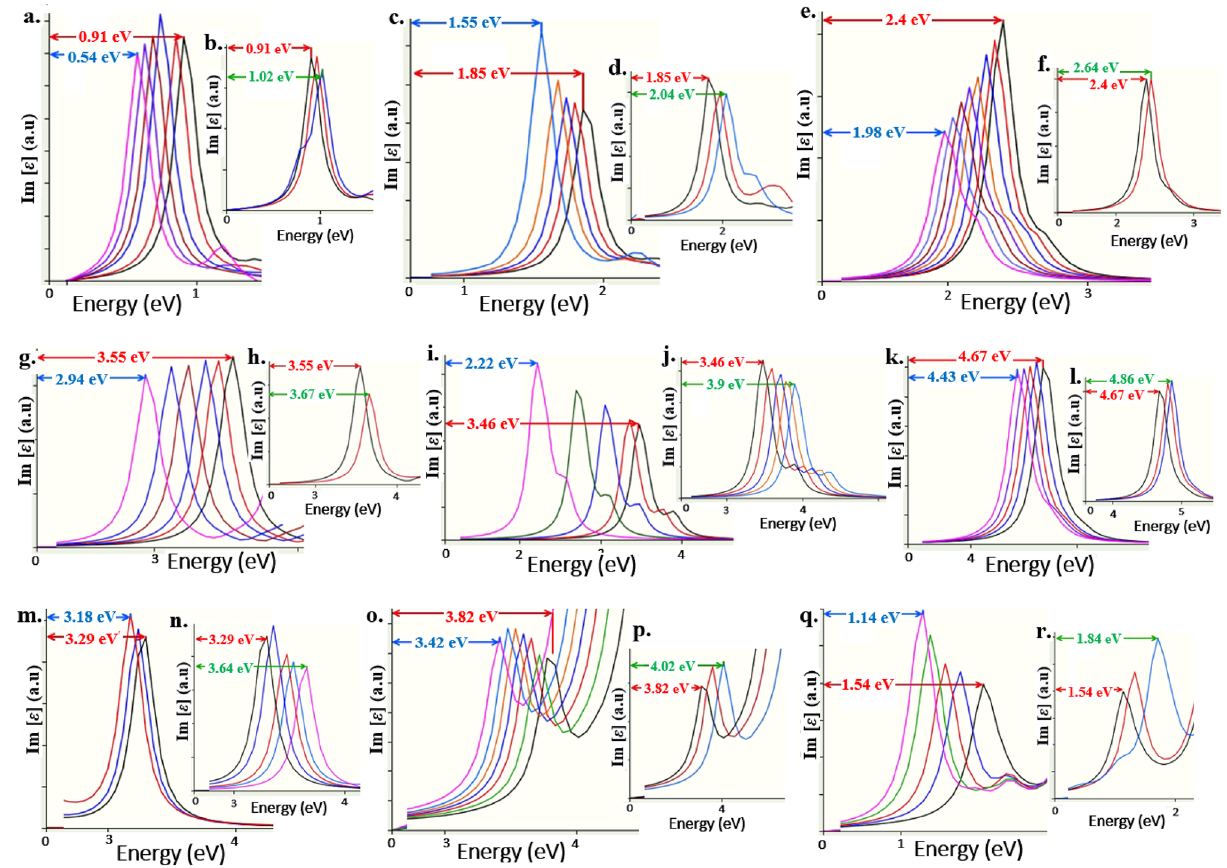
Figure 15. DFT computed, spin un-polarized quantum emission tunability of luminescent point defects to external strain inducement. All the emission spectrums towards left panel are quantum emission tunability towards lower energy region and emission spectrums towards right panel are tunability towards higher energy region. ( a , b ) Tunability of V B O 2 defect having ZPL at 0.91 eV. ( c ,d) Tunability of N B V N defect having ZPL at 1.85 eV. ( e , f ) Tunability of boron dangling bonds having ZPL at 2.4 eV. ( g , h ) Tunability of C B C N defect having ZPL at 3.55 eV. ( i , j ) Tunability of V BN defect having ZPL at 3.46 eV. ( k , l ) Tunability of V B defect having ZPL at 4.67 eV. ( m , n ) Tunability of V N defect having ZPL at 3.29 eV. ( o , p ) Tunability of C B defect (boron replaced by carbon) having ZPL at 3.82 eV. ( q , r ) Tunability of N AL V N defect in AlN (aluminum nitride) having ZPL at 1.54 eV. All red colour arrows indicate ZPL energy under no strain. All blue colour and green colour arrows indicate tuned ZPL energies towards lower energy regions and higher energy regions,